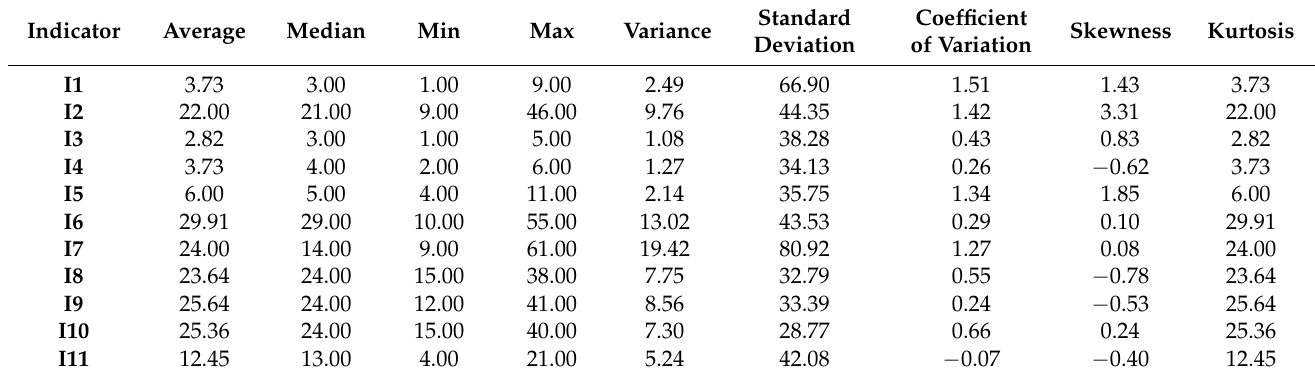
Table 4. Basic descriptive statistics of indicators for small enterprises in the CEE countries.